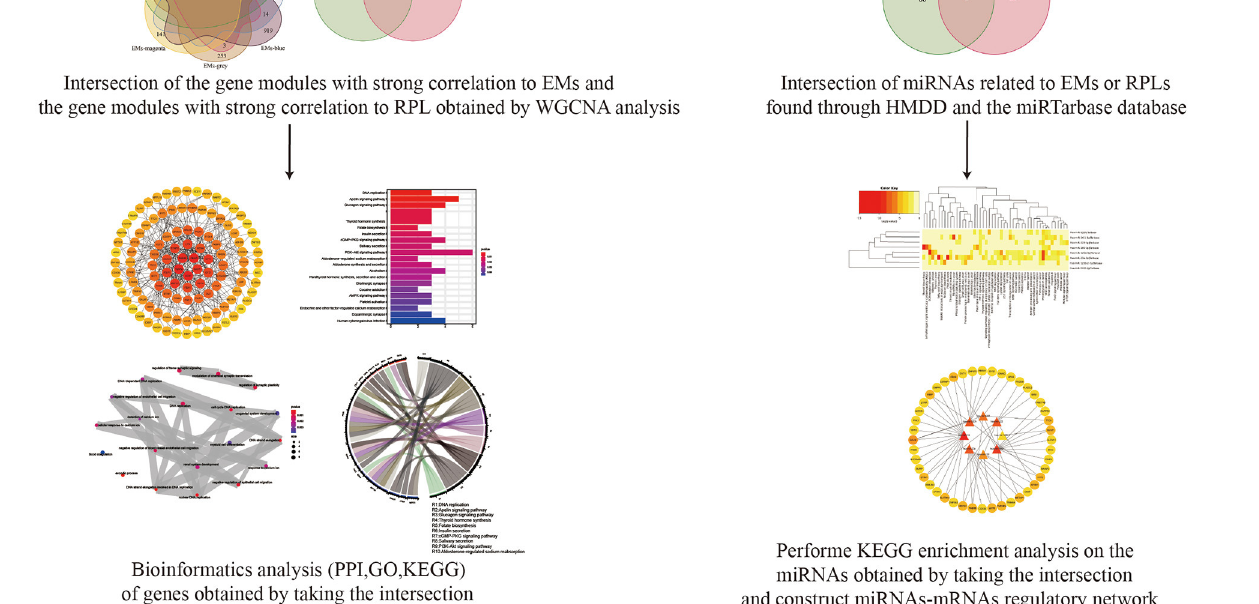
Frontiers in Veterinary Science |